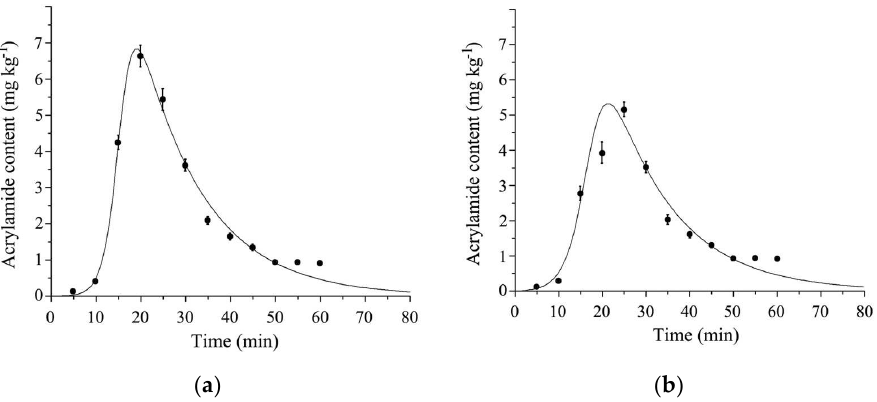
Figure 4. Logistic−exponential kinetic model fitting curves for acrylamide contents in garlic powder. ( a ) AA content of fried potato without garlic powder soaking treatment; ( b ) AA content of fried potato with garlic powder soaking treatment.